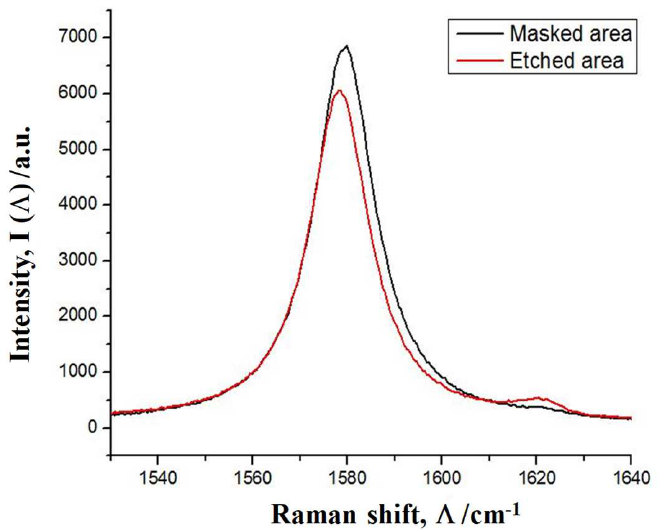
Figure 8. Comparison of the Raman spectra before and after oxygen plasma etching.